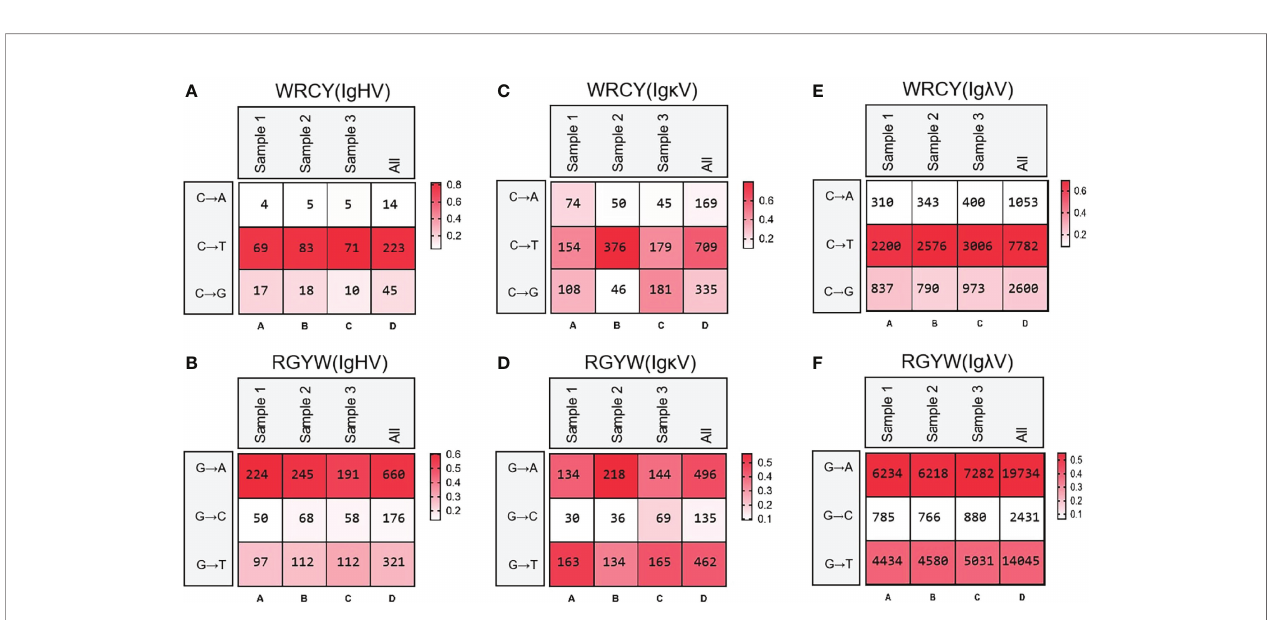
FIGURE 8 | The somatic hypermutation (SHM) of yak IgL( k ). (A – F) The distribution of SHM in yak IgL( k ); (G – J) The base mutation types of SHM in yak IgL( k ).